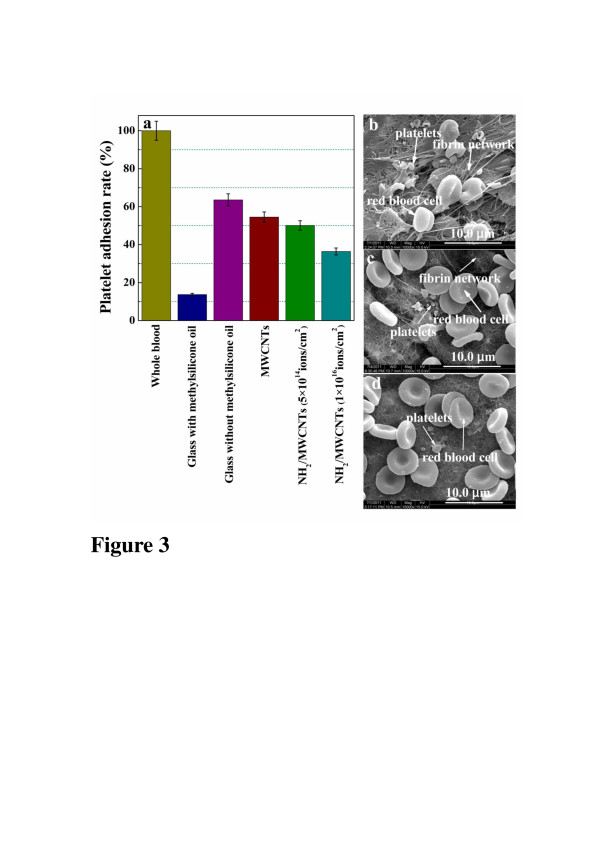
Platelet adhesion rates of the samples and SEM images of RBCs and platelets. (a) Platelet adhesion rates on different samples. SEM images of RBCs and platelets on (b) pristine MWCNTs, (c) NH2/MWCNTs with 5 × 1014 ions/cm2, and (d) NH2/MWCNTs with 1 × 1016 ions/cm2.